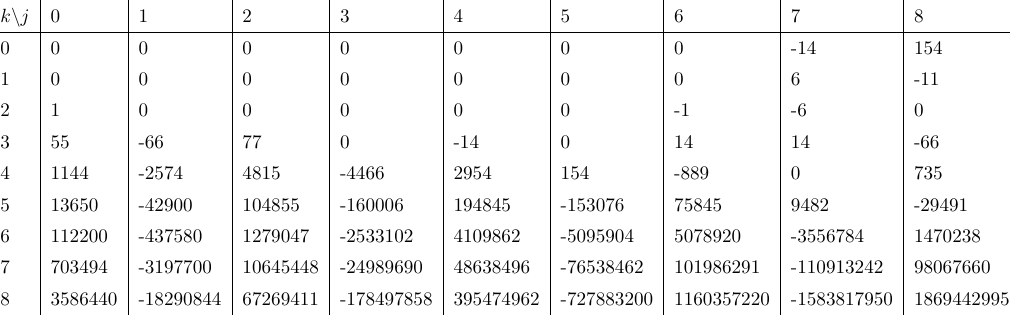
Table 76. Table of b jk coe(cid:14)cients for h SO(11)